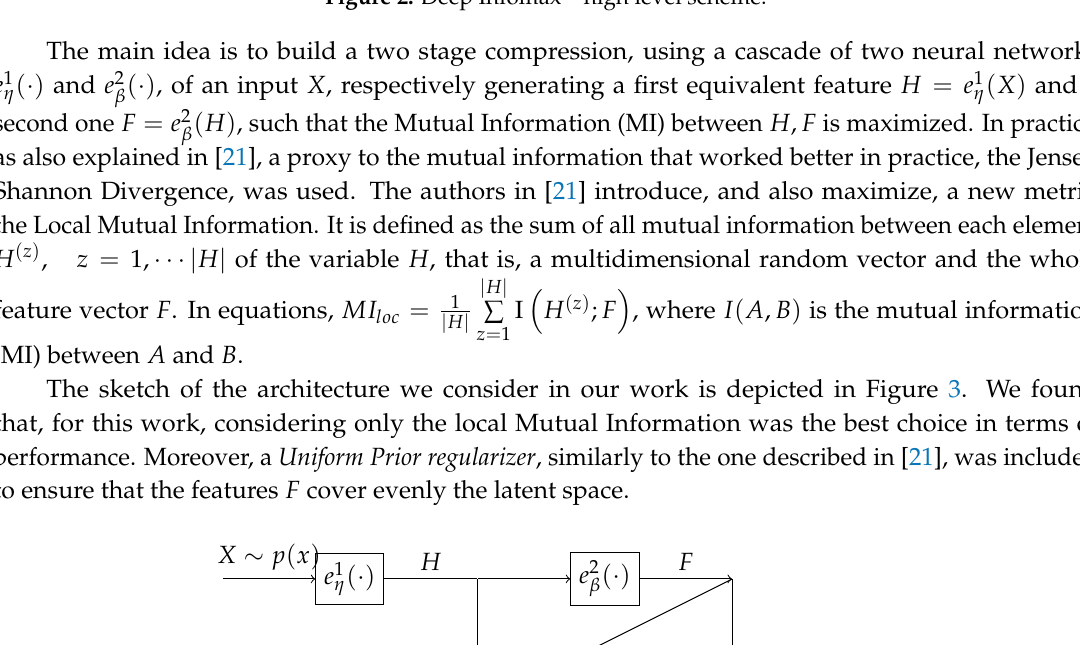
Figure 2. Deep Infomax—high level scheme.